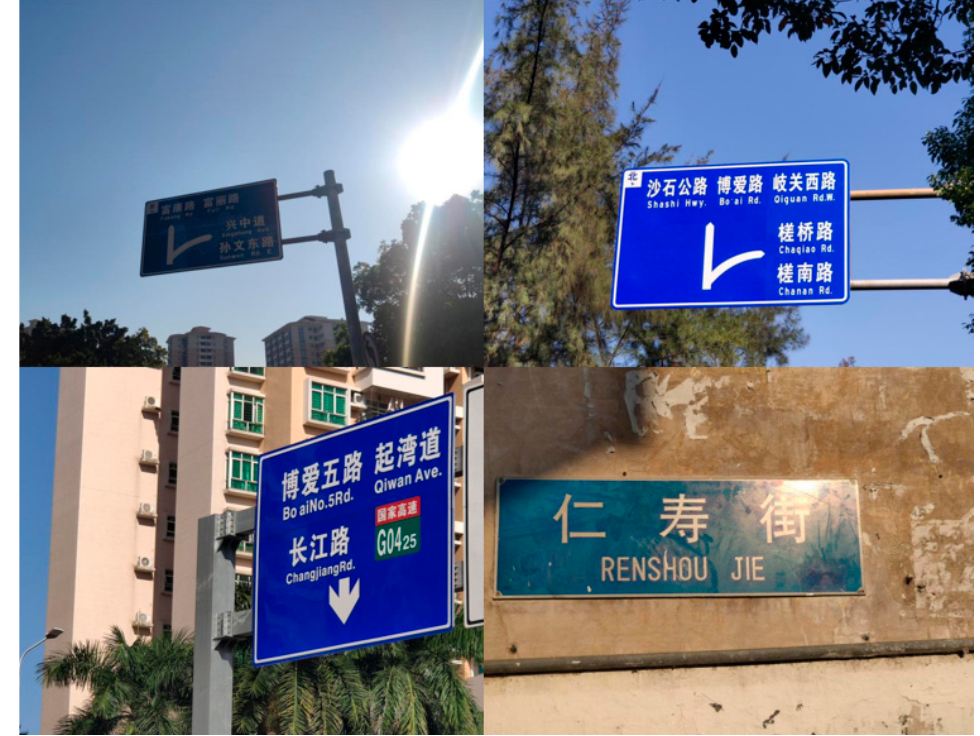
Figure 8. Partial images of the NSSS dataset.